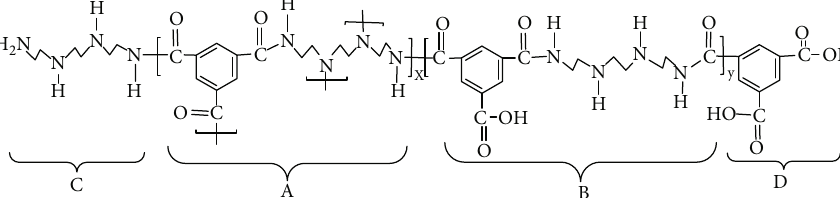
Figure 16: Possible polymerization reaction between triethylenetetramine and 1,3,5-benzenetricarboxylic acid chloride. (a) Totally cross- linked polymer chain, (b) polymer chain with pendant-NH and -COOH, (c) pendant chain with pendant-NH polymer chain with pendant-COOH.